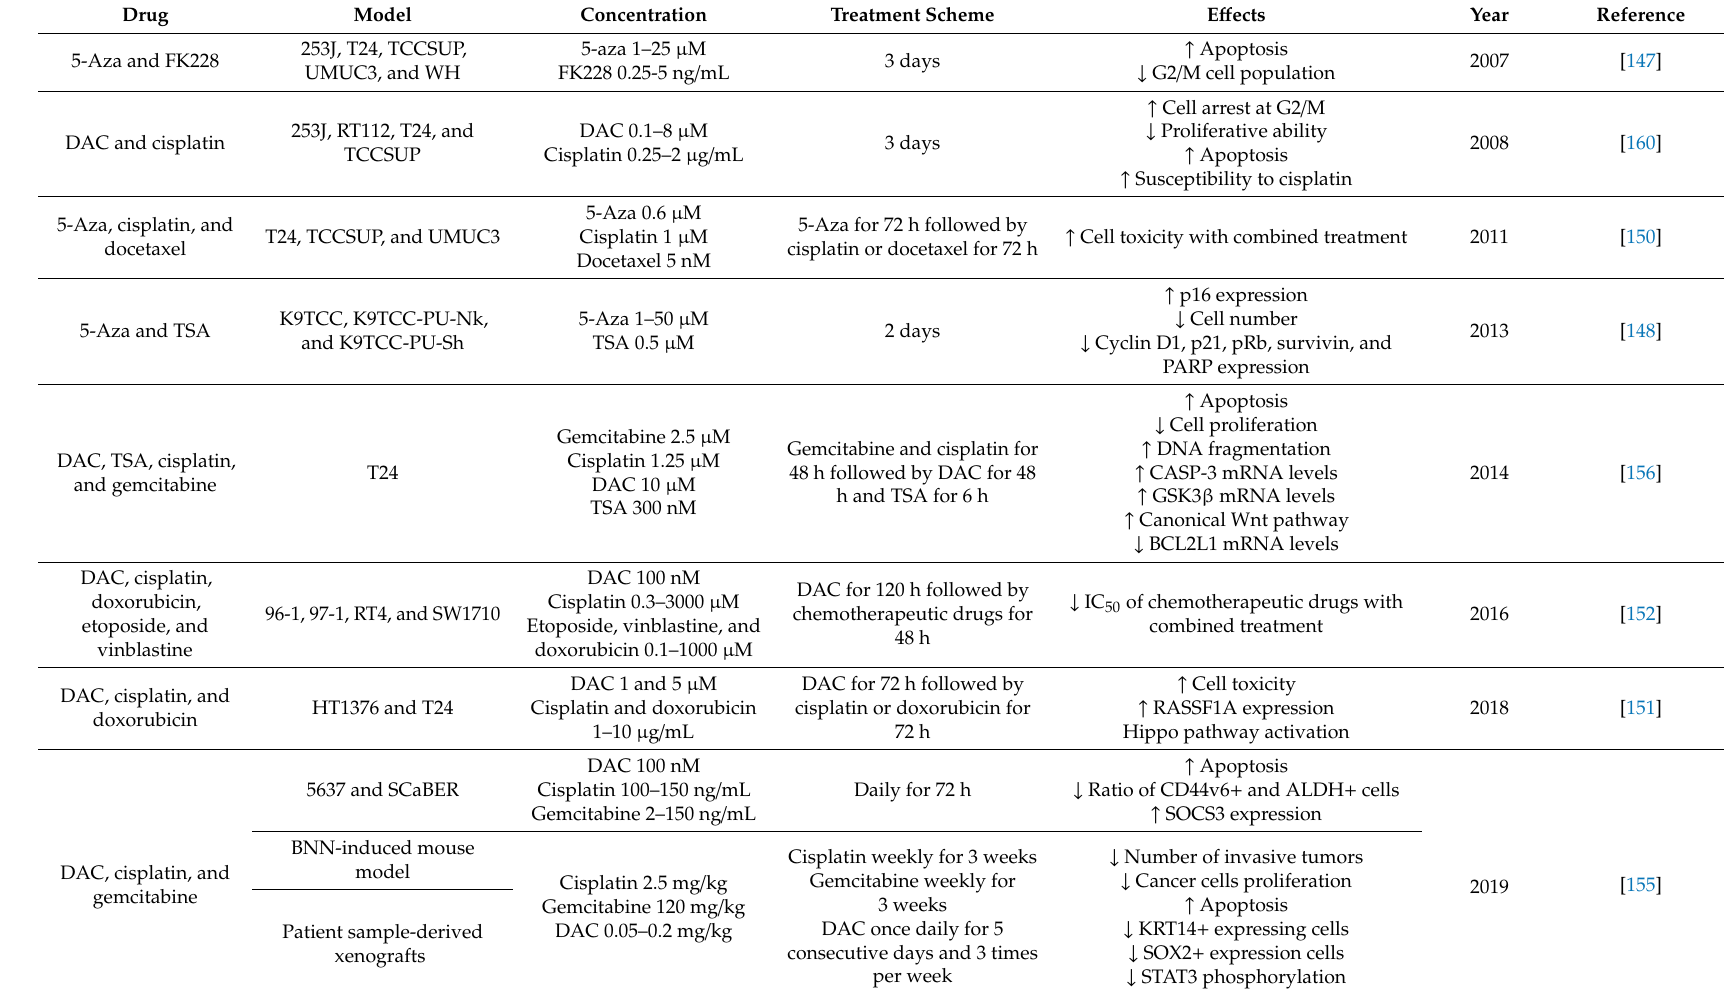
Table 2. Summary of combination studies targeting DNMTs in